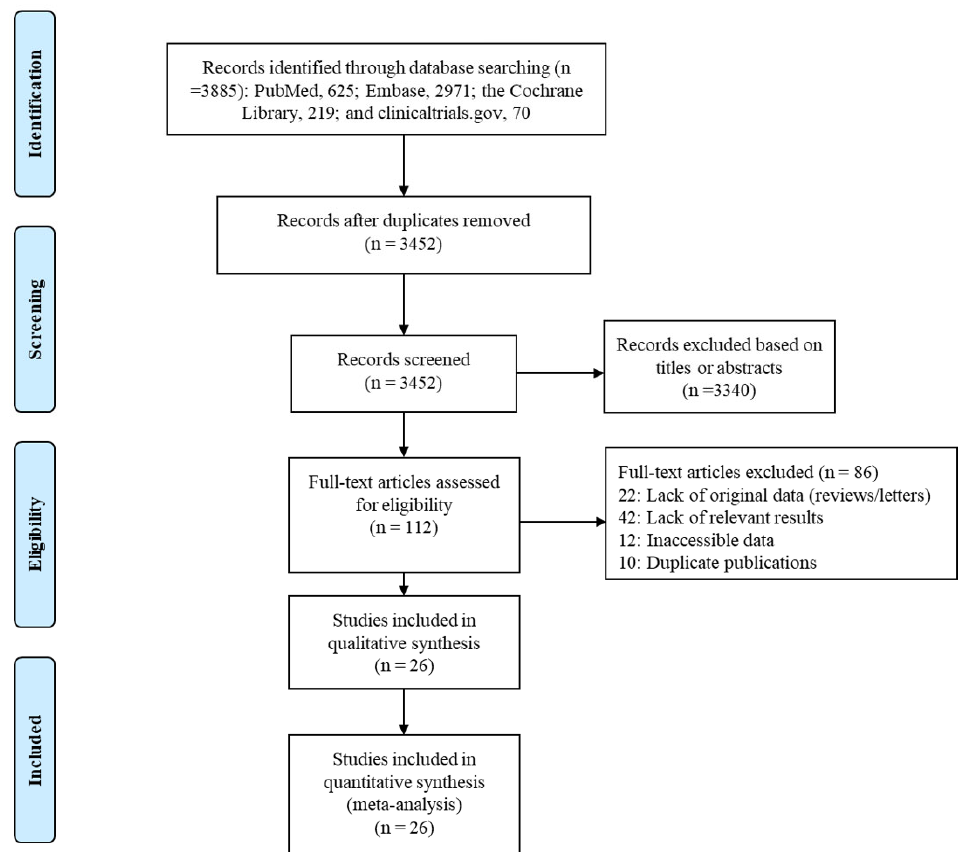
Figure 1. Flow diagram of study selection process.